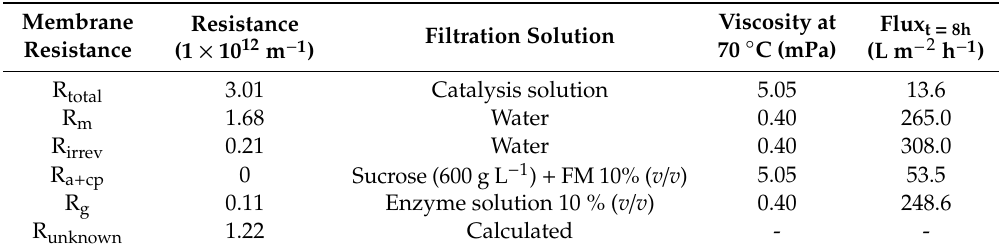
Table 5. Calculated resistance values.